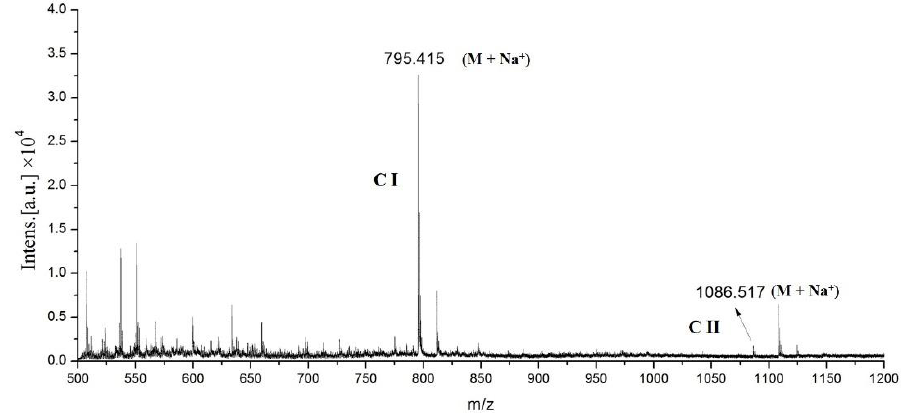
Figure 3. MS analysis of UHFA-based solid-phase sequential OPME synthesis of Compound II (C II). Continuous UHFA-based solid-phase sequential synthesis of biotinylated 6′-sialyl- N -acetylglucosamine catalyzed by OPME 1 and OPME 2 was not attempted due to the